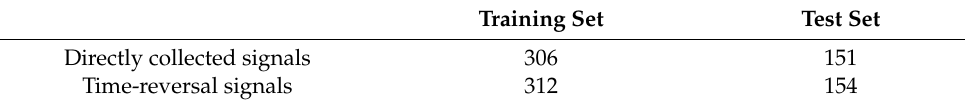
Table 3. Data set distribution.